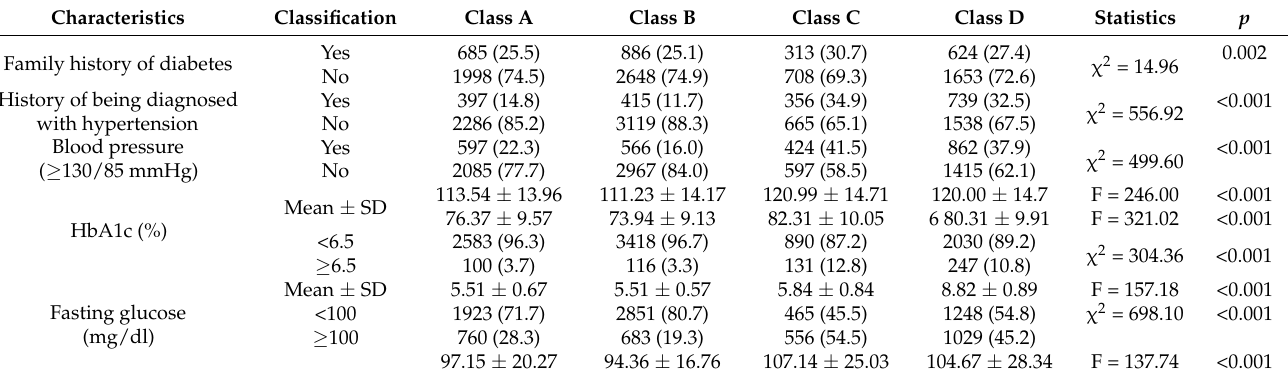
Table 4. Differences in the disease history and laboratory characteristics of the four latent classes.